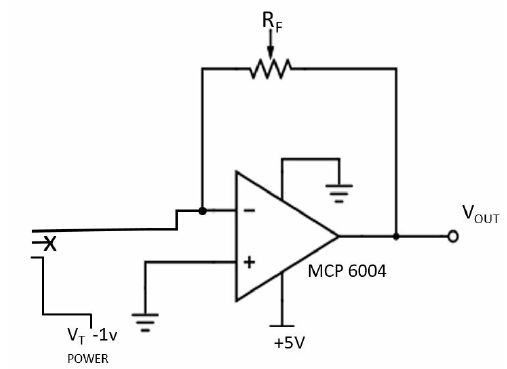
Figure 6. Configuration of the test bench: ( a ) the resonator and force sensors; ( b ) wooden test bench.